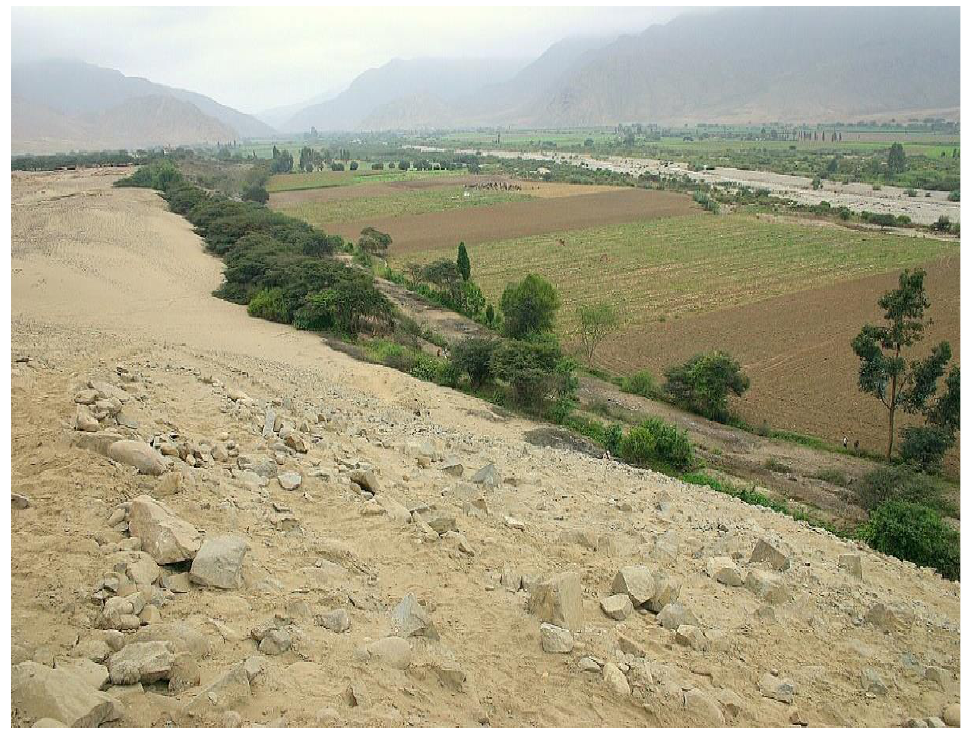
Figure 33. Present-day Supe Valley bottomland agricultural area; Caral situated on left elevated plateau. Photo by author.